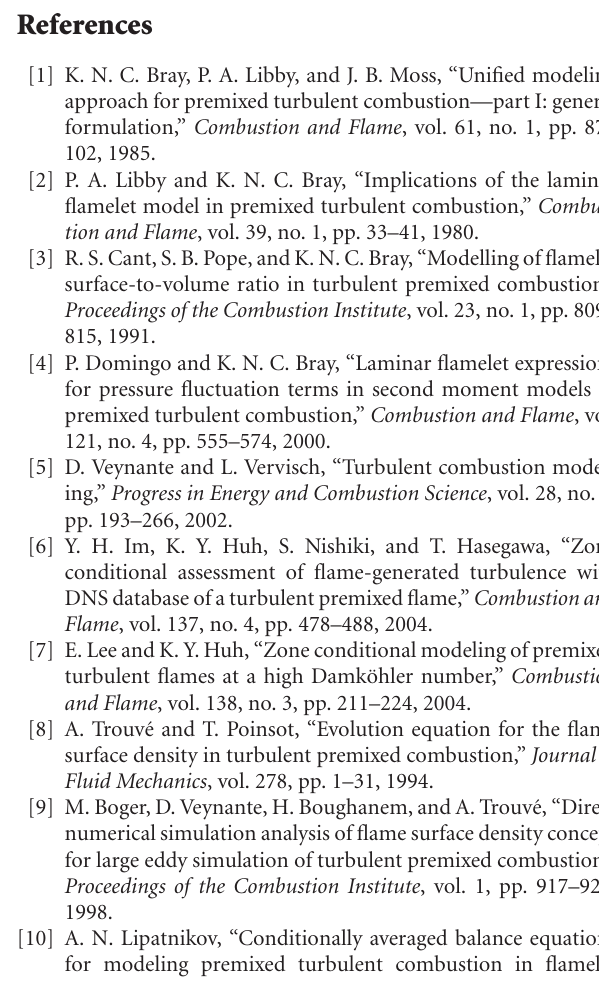
2 with (cid:2) c across the flame brush. (b) Variations of ( u 2 u 2 ) P /S L